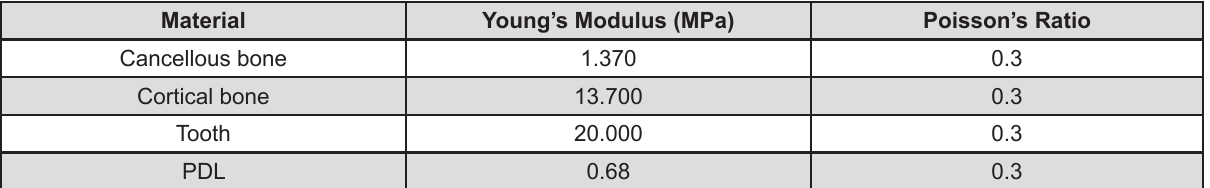
Figure 5- Mechanical properties of the materials used in the finite element models PDL=periodontal ligament